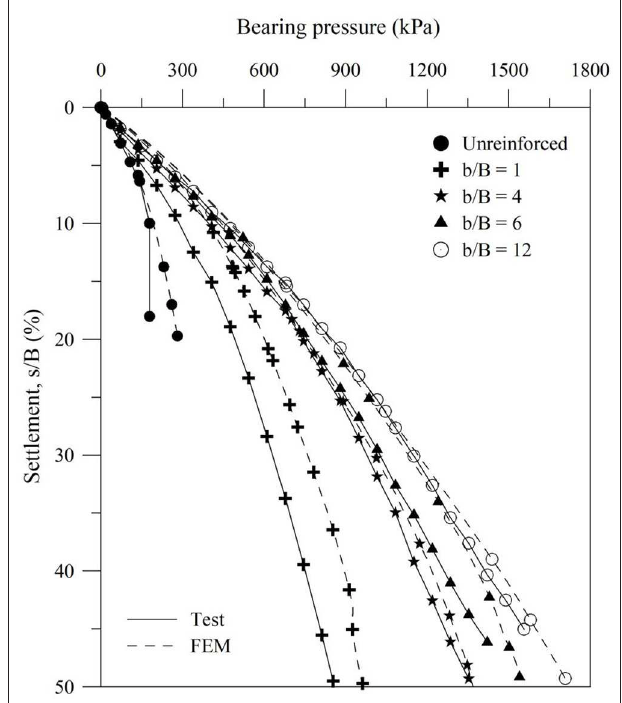
FIGURE 5 | Variation of bearing pressure with footing settlement for different widths of geocell mattress ( d/b = 1.2, h/b = 2.75, u/b = 0.1, ID = 70%).